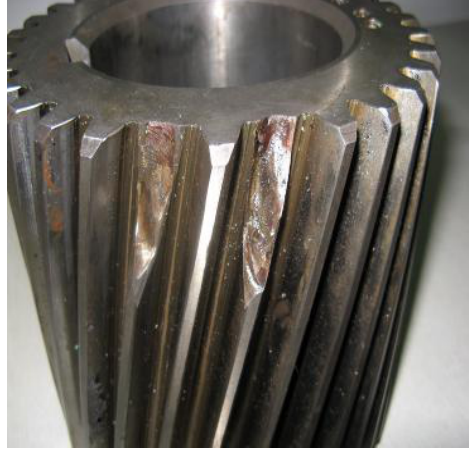
Figure 17. Fault gear Z5 on shaft II of the bevel box.